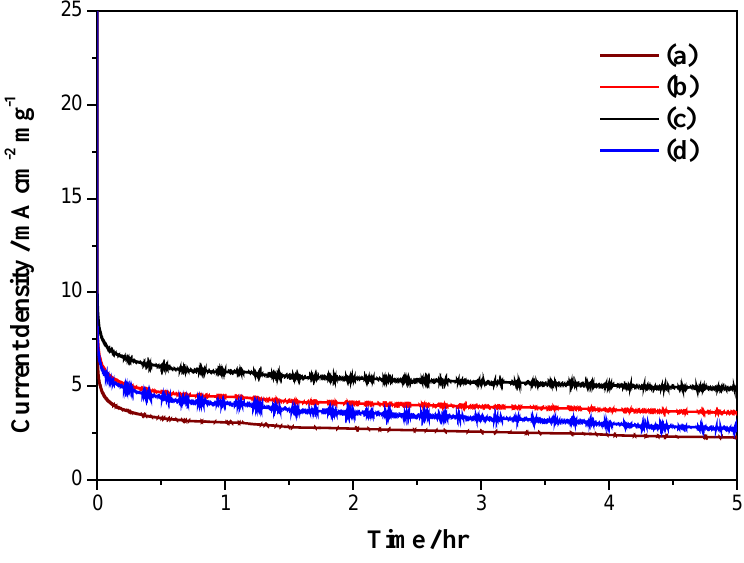
Figure 11. Chronoamperometric responses of ( a ) PICA-Pt; ( b ) P(ICA4- co -EDOT1)-Pt; ( c ) P(ICA3- co -EDOT2)-Pt; and ( d ) P(ICA2- co -EDOT3)-Pt at 0.6 V ( vs. Ag/AgCl) in 0.5 M CH 3 OH + 0.5 M H 2 SO 4